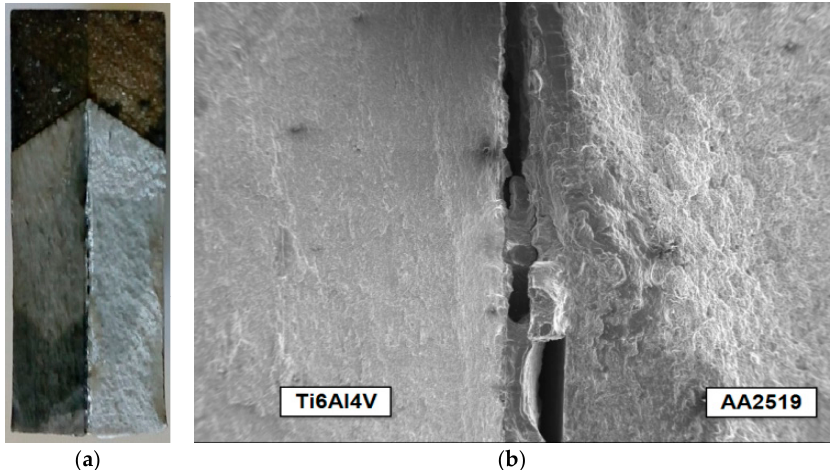
Figure 3. Delamination crack: ( a ) total view of fracture surface of the SENB specimen; ( b ) development of the delamination crack.